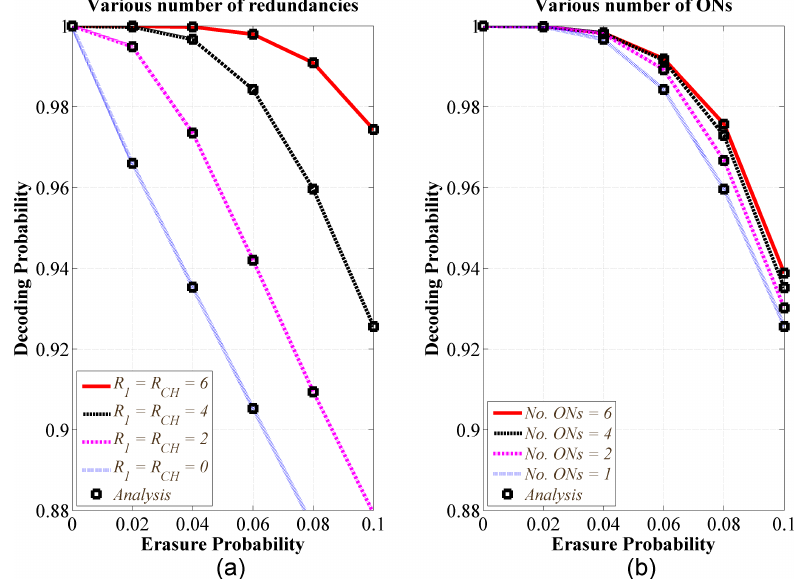
Figure 7. ( a ) Decoding probability versus erasure probability with various redundancies and a single ON; ( b ) Decoding probability versus erasure probability with various numbers of ONs and redundant packets of 4; K = 30, and q =